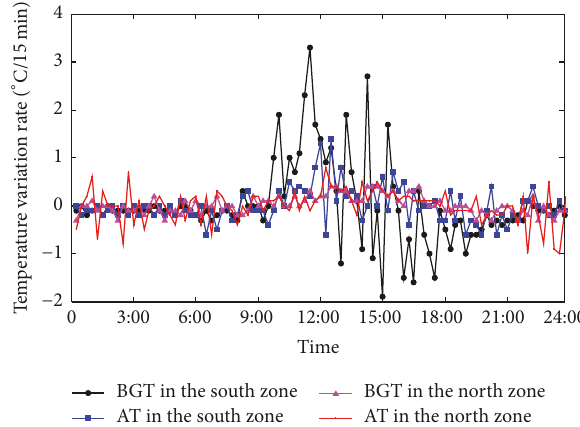
Figure10:Comparisonofthethermalenvironmentinthesouthand north